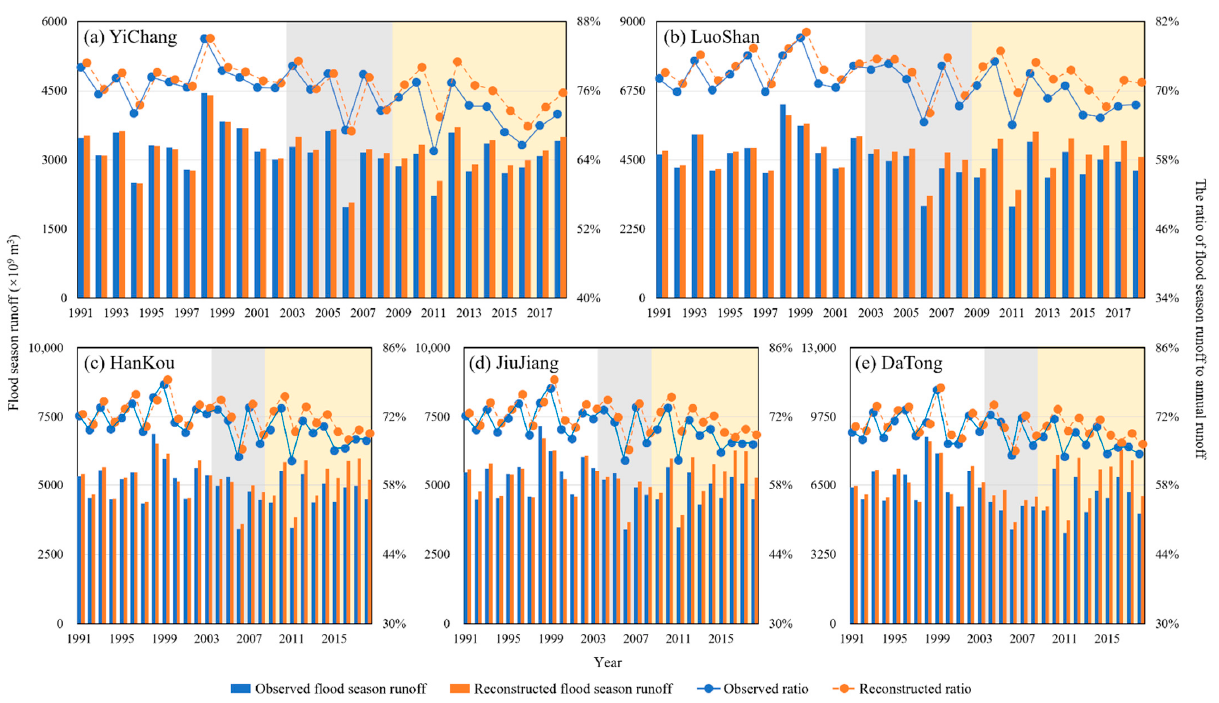
Figure 12. Analysis of the flood season runoff in the five gauging stations (the grey zones denote the initial operation period of the TGD from 2003 to 2008, and the yellow zones denote the full operation period of the TGD from 2009 to 2018).